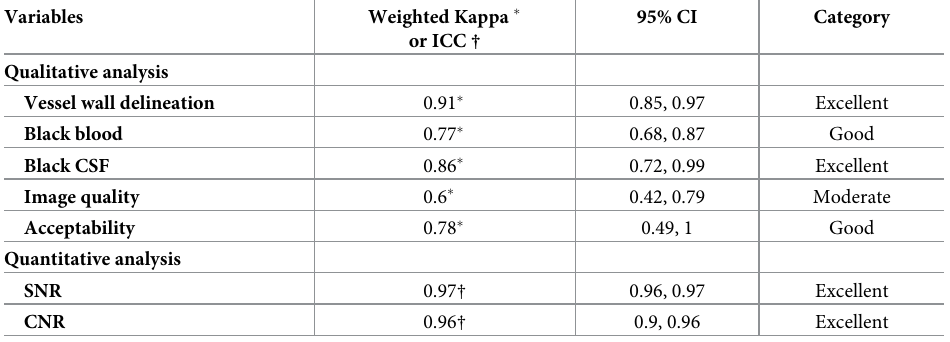
Table 3. Interobservor agreements between two radiologists in qualitative and quantitative analyses.